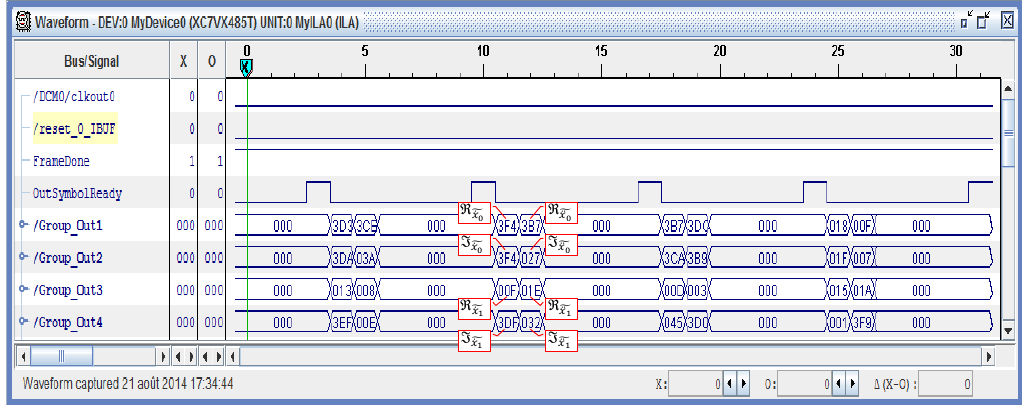
Figure 14. ChipScope Pro Analyzer software waveform window.